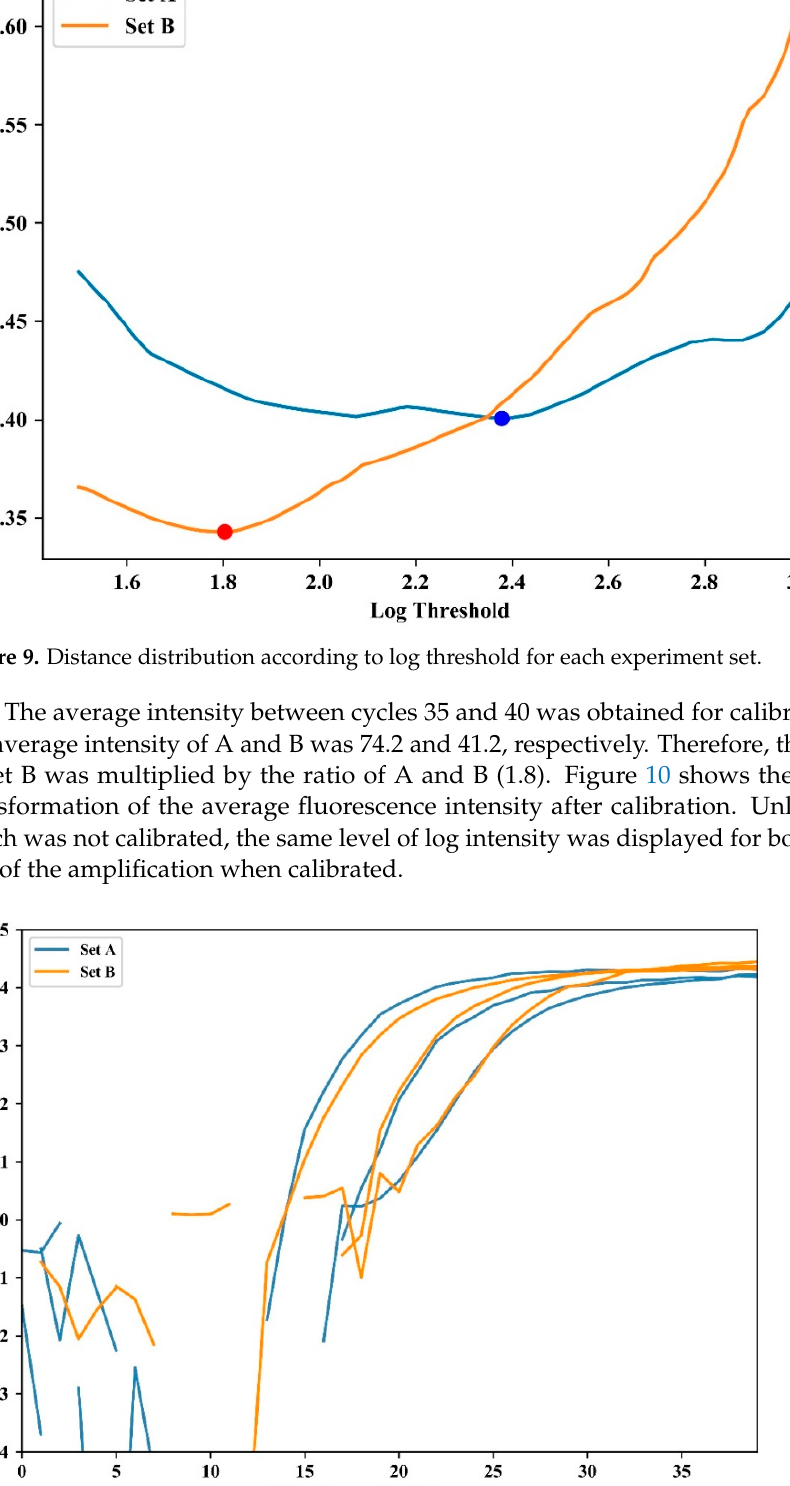
Figure 10. Logarithmic transformation of the fluorescence intensity of the entire experiment after the calibration